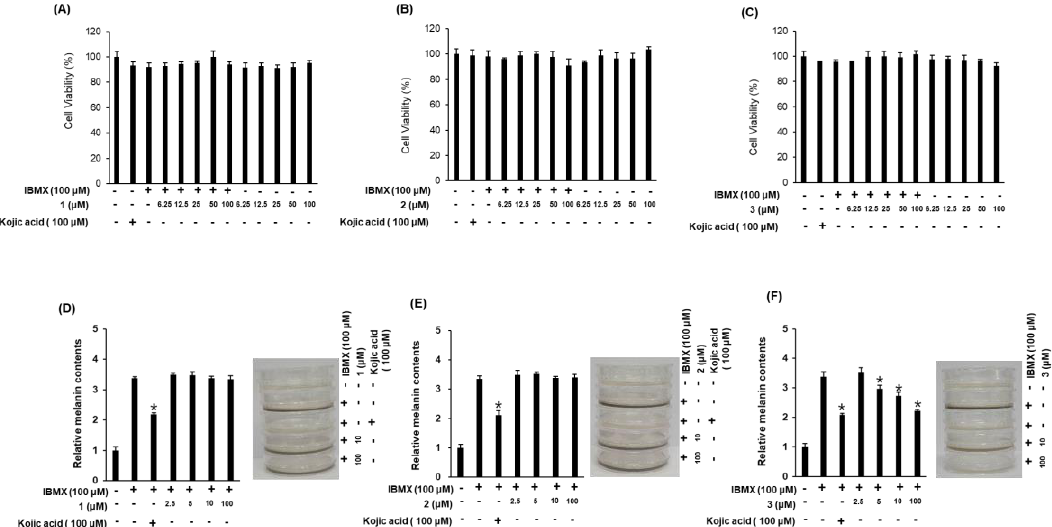
Figure 5. Inhibitory effects of compounds 1 – 3 on melanin content in B16F10 cells. ( A – C ) Effects of compounds 1 – 3 on cell viability. ( D – F ) Inhibitory effects of compounds 1 – 3 on IBMX-induced melanin production in B16F10 melanoma cells (mean ± SD, * p < 0.05 compared to the IBMX-treated